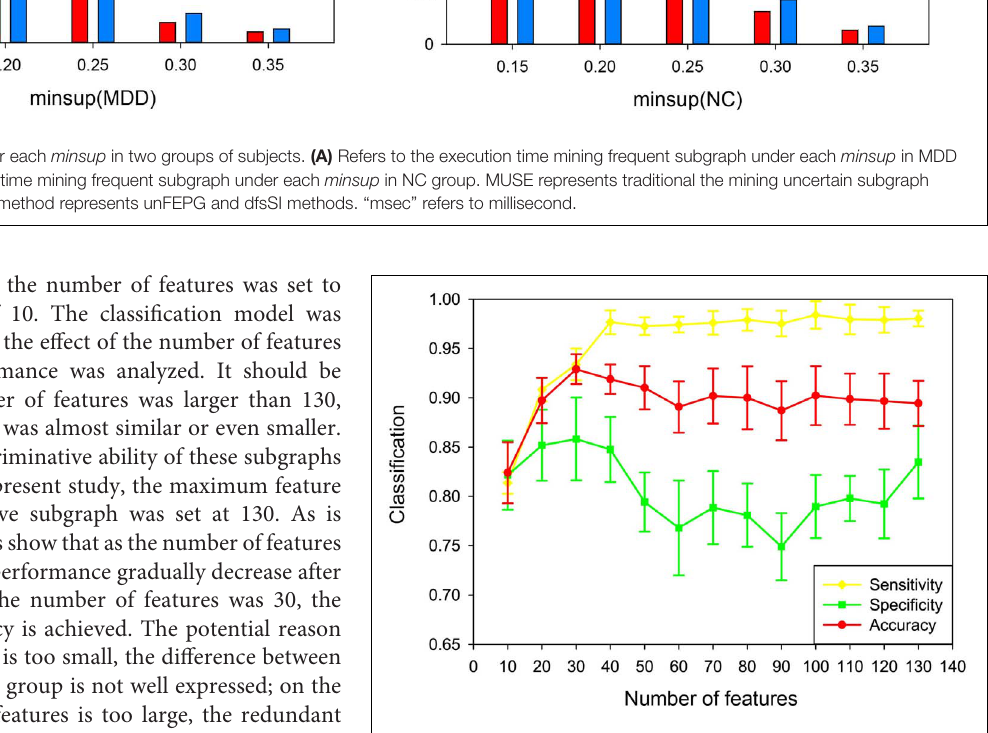
FIGURE 9 | Classification performance based on different feature numbers in the uncertain brain network. Yellow denotes the sensitivity in different feature numbers. Green denotes the specificity in different feature numbers. Red denotes the accuracy in different feature